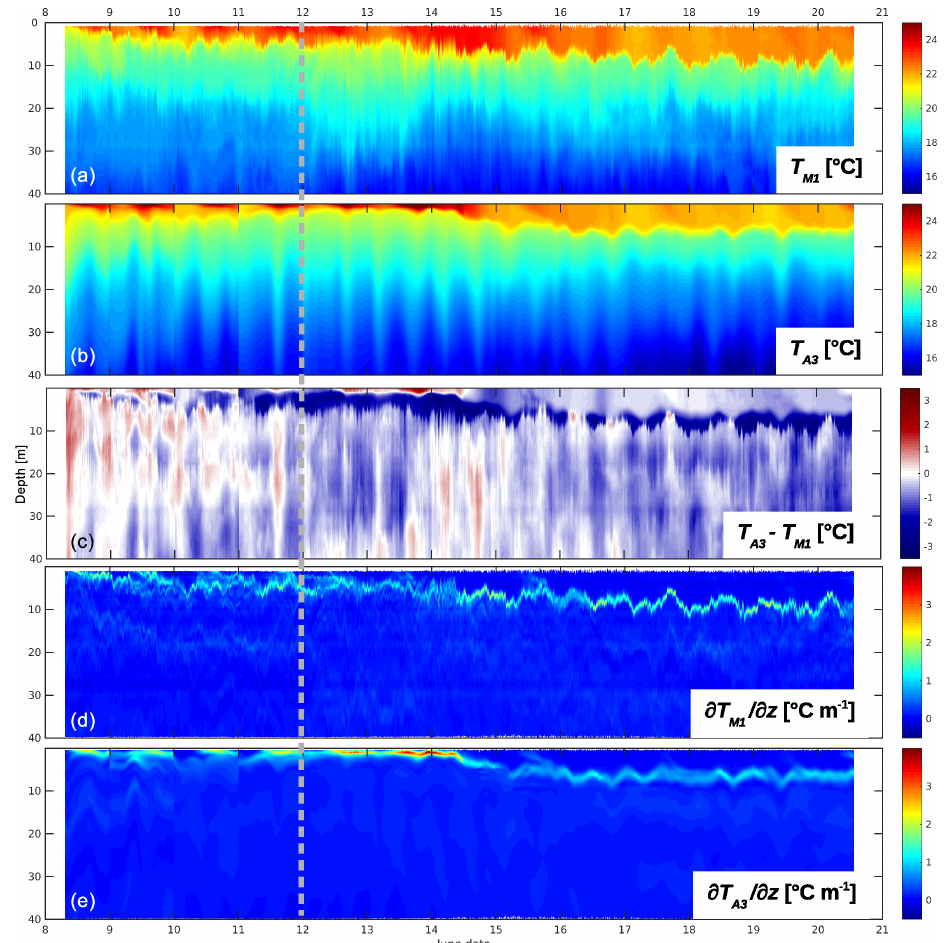
Figure 10. (a) The observed temperature at mooring M1, (b) the modelled temperature from ROMS run A3, and (c) the difference between the modelled and the observed temperature. The vertical temperature gradient from (d) the observations and (e) from A3. The instant of the last data assimilation is indicated by the the grey dashed vertical line.